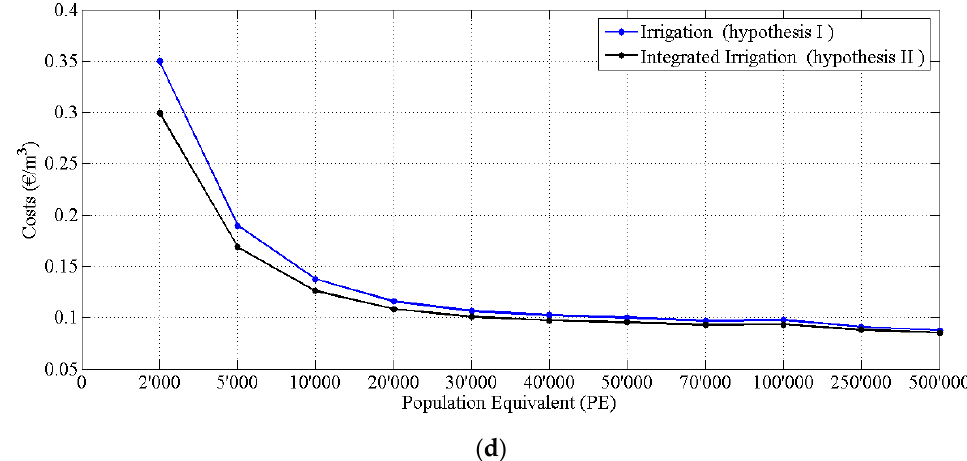
Figure 3. Estimated costs of reclaimed wastewater at plant gate: ( a ) Alt 1; ( b ) Alt 2; ( c ) Alt 3; and ( d ) Alt 4.